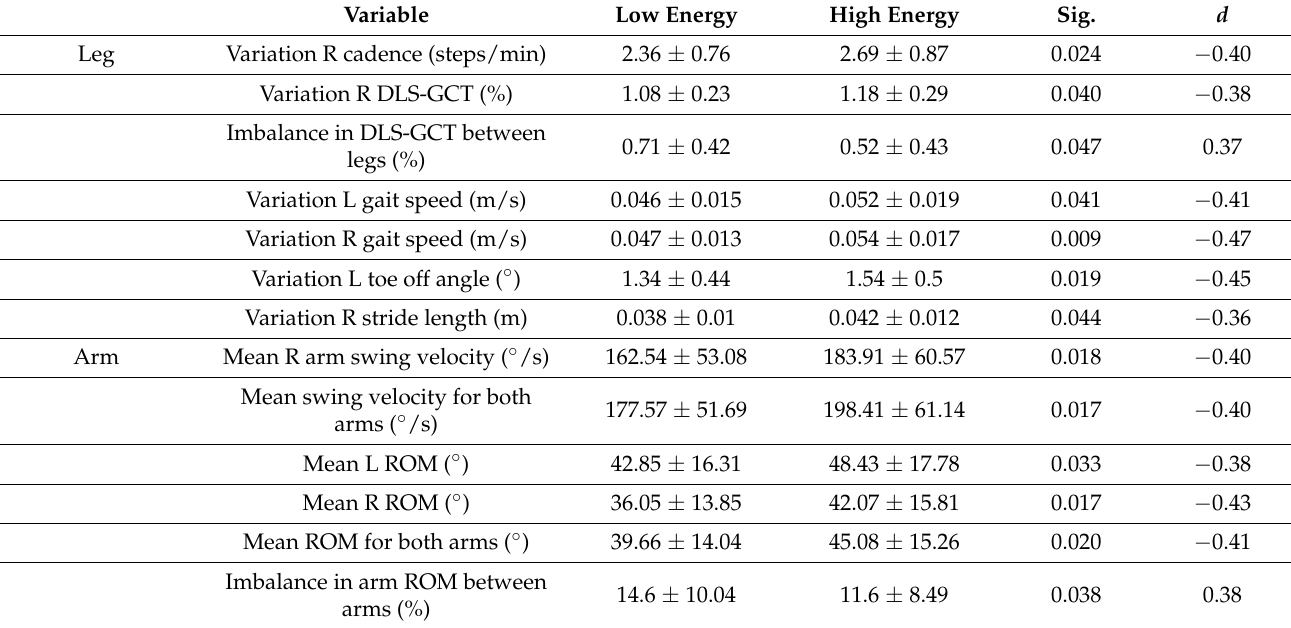
Table 5. Differences between high- and low-energy groups (mean ±